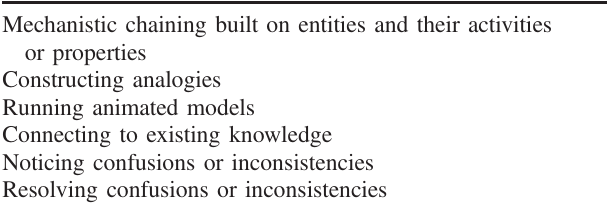
TABLE I. Signs of in-the-moment productivity. Mechanistic chaining built on entities and their activities or